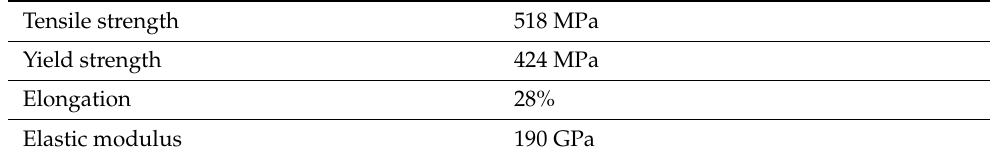
Table 3. Mechanical properties of welding wire grade AWS A5.18 ER 70S-6. Table 2. Chemical composition of S20C steel base.